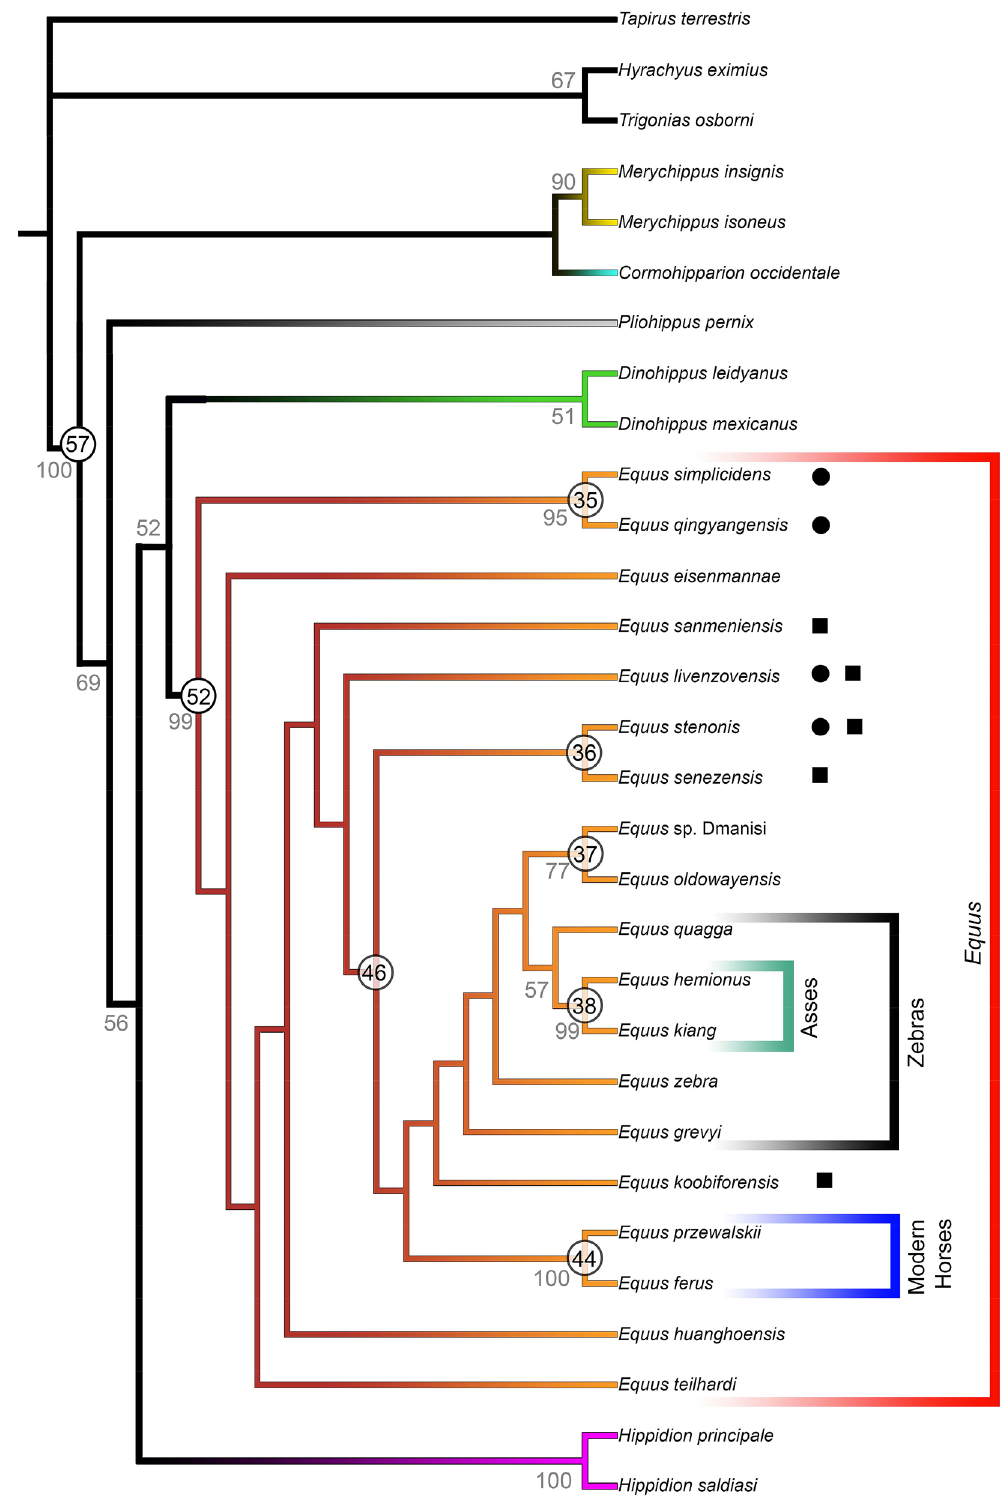
Figure 2. Most parsimonious tree of the cladistic analysis (30 taxa; 129 characters; Length = 398; CI = 0.472; RI = 0.705; HI = 0.528) recovered by PAUP 4.0β10 47 and edited by Adobe Photoshop CC2017. Grey numbers report the Bootstrap values, whereas numbers included in circles represent the nodes discussed in the text. Terminal color branches indicate the following different genera identified by the cladistic analysis: yellow, Merychippus ; Cyan, Cormohipparion ; grey, Pliohippus ; purple, Hippidion ; green, Dinohippus ; dark red to orange, Equus . On the right, red color box indicates the genus Equus , black box Zebras, dark green box Asses and blue box Modern Horses. Black circles indicate the previous genus attribution to Plesippus , whereas black squares Allohippus . The detailed analyses are reported in Appendix